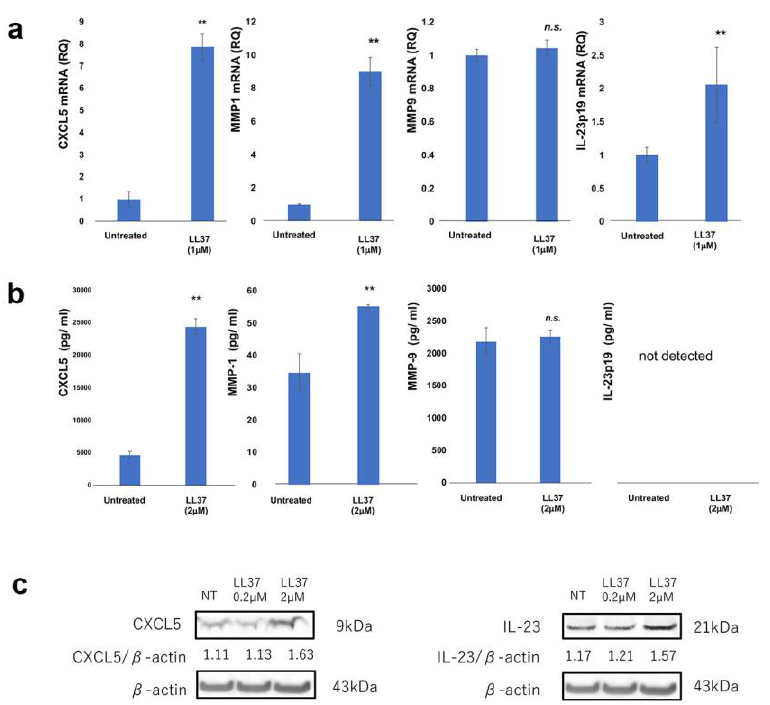
Figure 4. Expression of IL23A , CXCL5 , MMP1 , and MMP9 mRNA in M2 macrophages stimulated with or without LL-37 were analyzed by quantitative RT-PCR using the ∆∆ Ct method (n = 3). The data from each donor were obtained by triplicate assays, and then the mean ± SD was calculated. ( a ) Culture supernatant from M2 macrophages was harvested as described in Materials and Methods and measured by ELISA (n = 3). Data from each donor were obtained from triplicate assays, and mean ± SD values were calculated. Representative data from at least three independent experiments are shown ( b ). ** marks a significant ( p < 0.01) difference. CXCL5 and IL-23p19 production was analyzed by Western blotting ( c ). The uncropped blots are shown in Figure S2. n.s.: not significant